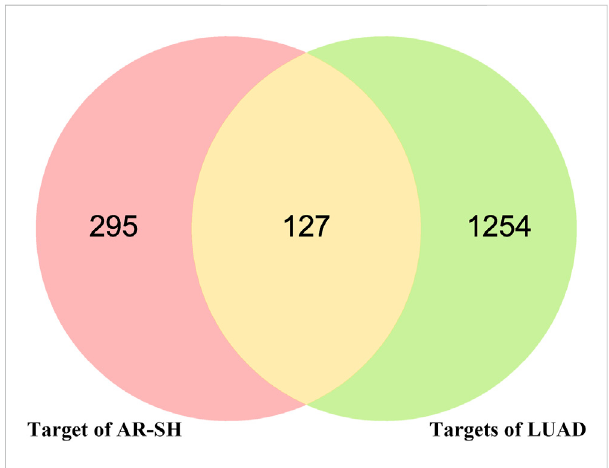
FIGURE 2 Venn diagram of AR-SH and LUAD intersected targets.